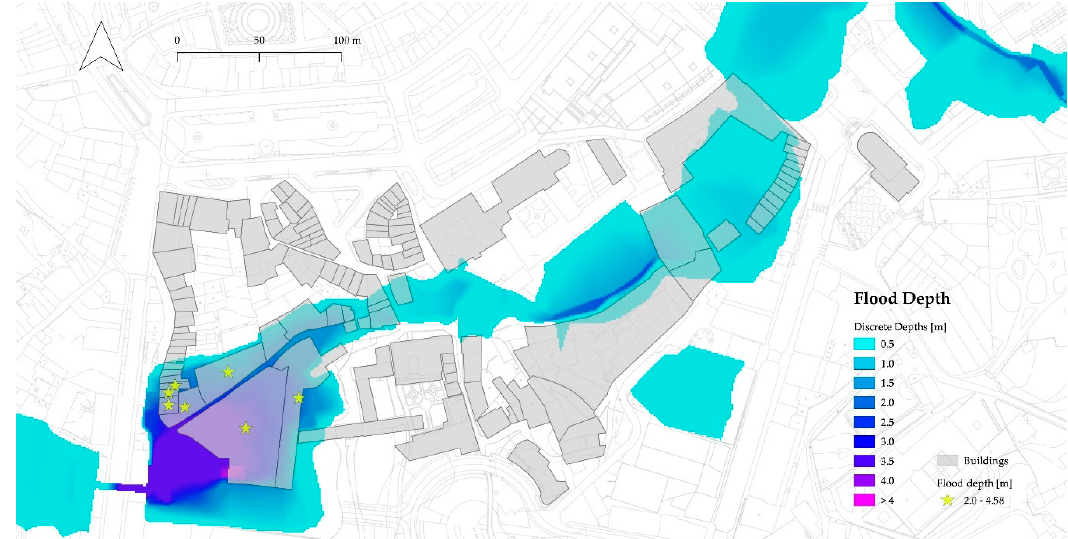
Figure 6. Water depth resulted from the adopted 100-year peak flow